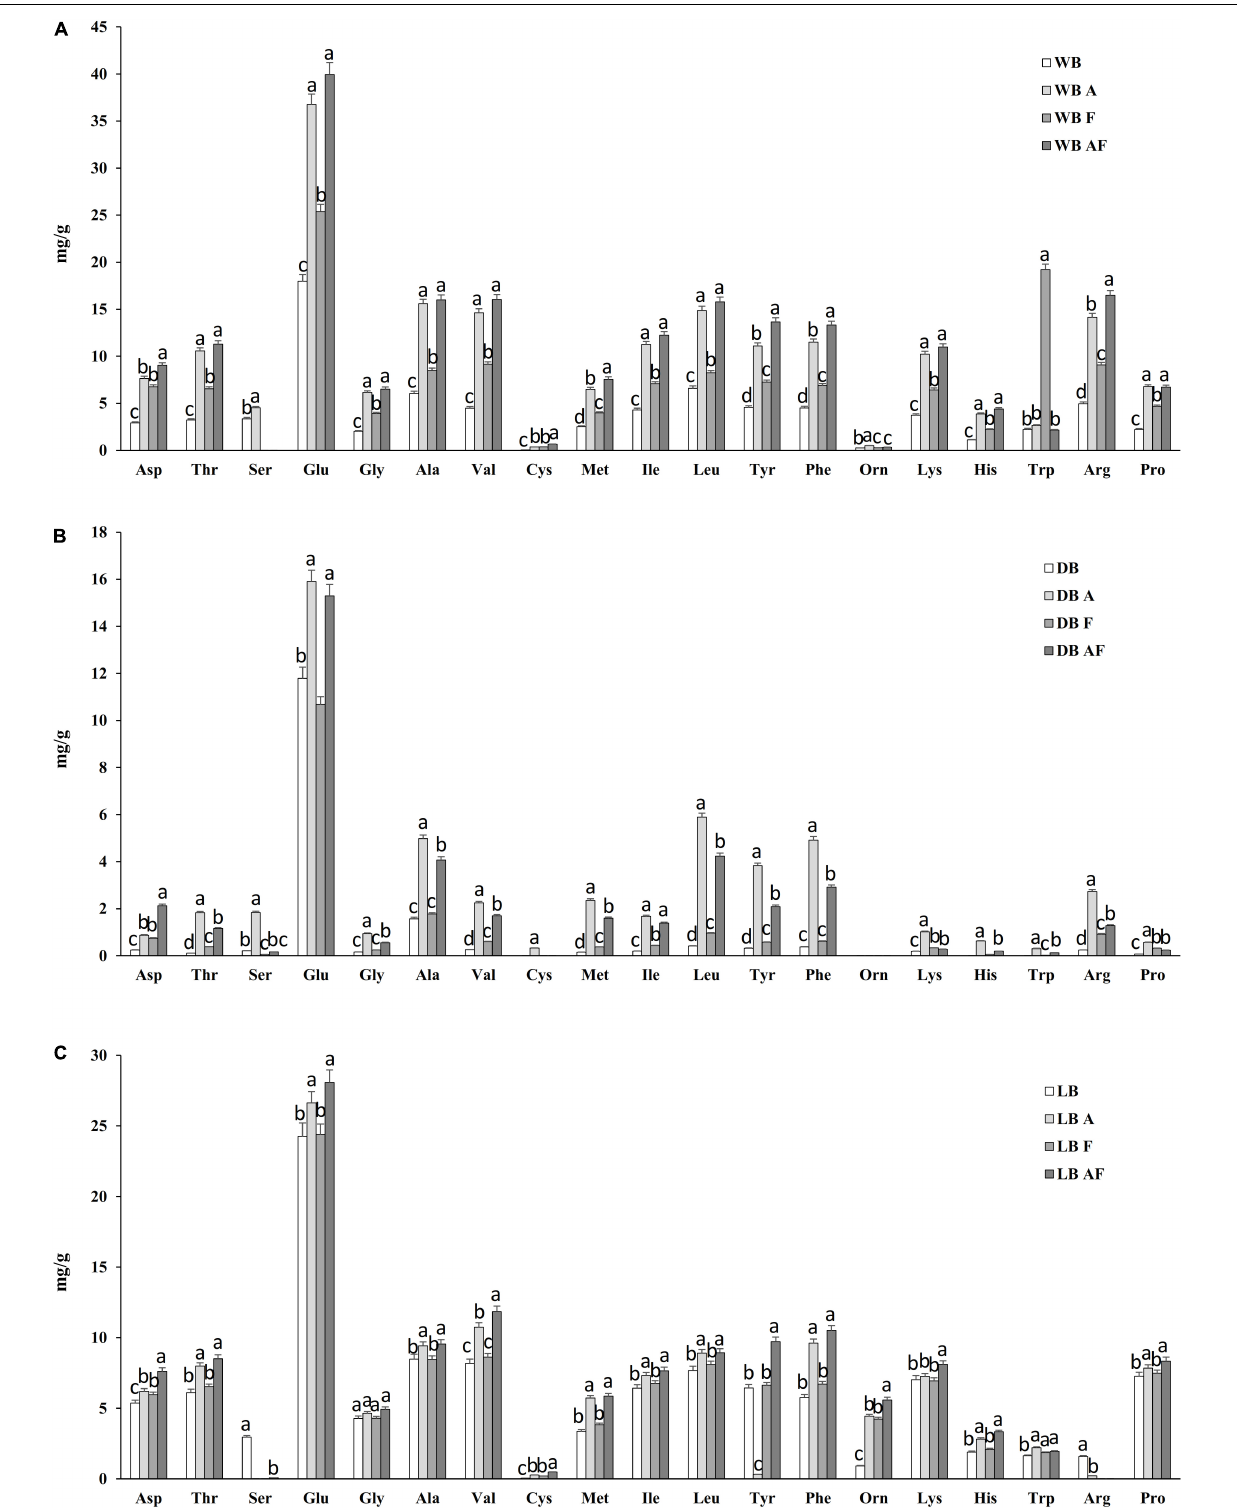
Frontiers in Microbiology |